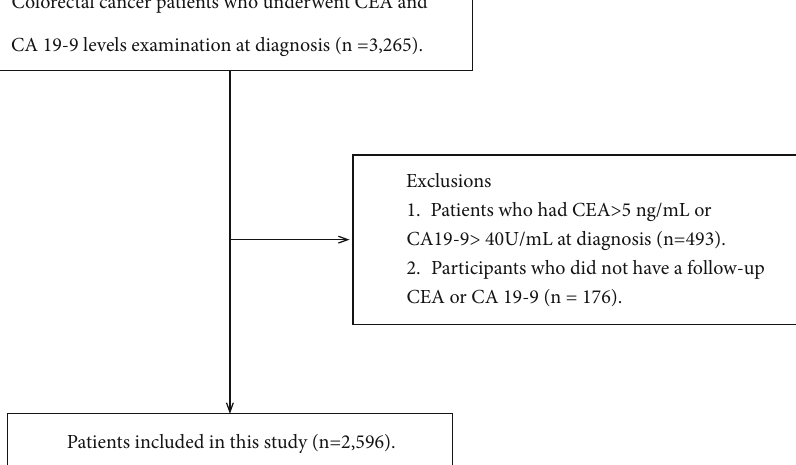
Figure 1: Schematic diagram for patient